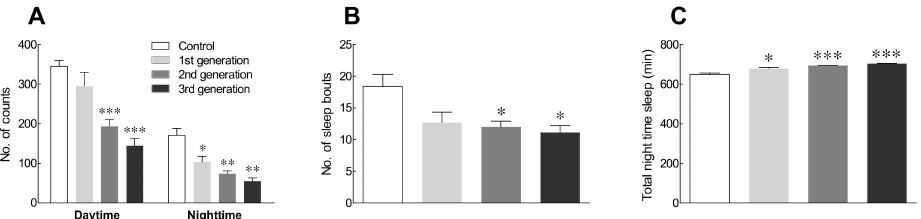
Figure 3. Effects of the GABA/5-HTP mixture (1.0% and 0.1%, respectively) on the locomotor activity of Drosophila flies by generation. Behavioral analysis was performed under constant darkness (DD) for five days. ( A ) Subjective nighttime activity, ( B ) number of sleep episodes, and ( C ) subjective nighttime sleep duration, as measured using the Drosophila activity monitoring system. Activity was measured as counts per min and calculated over five days. Data are presented as means ± standard error of the mean for each group. Mean values with different letters over the bars indicate significant difference (* p < 0.05, ** p < 0.01, and *** p < 0.001) according to Student’s t -test.